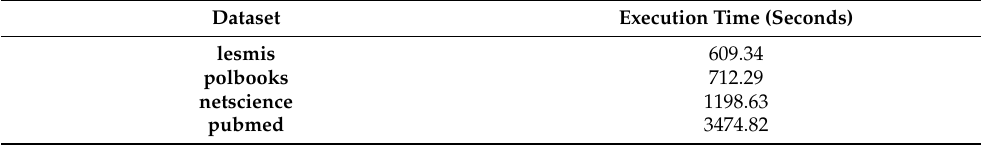
Table 9. Runtime for FONDUE-NDD in seconds, for 100 iterations (contracting each time a different random node pair and computing its